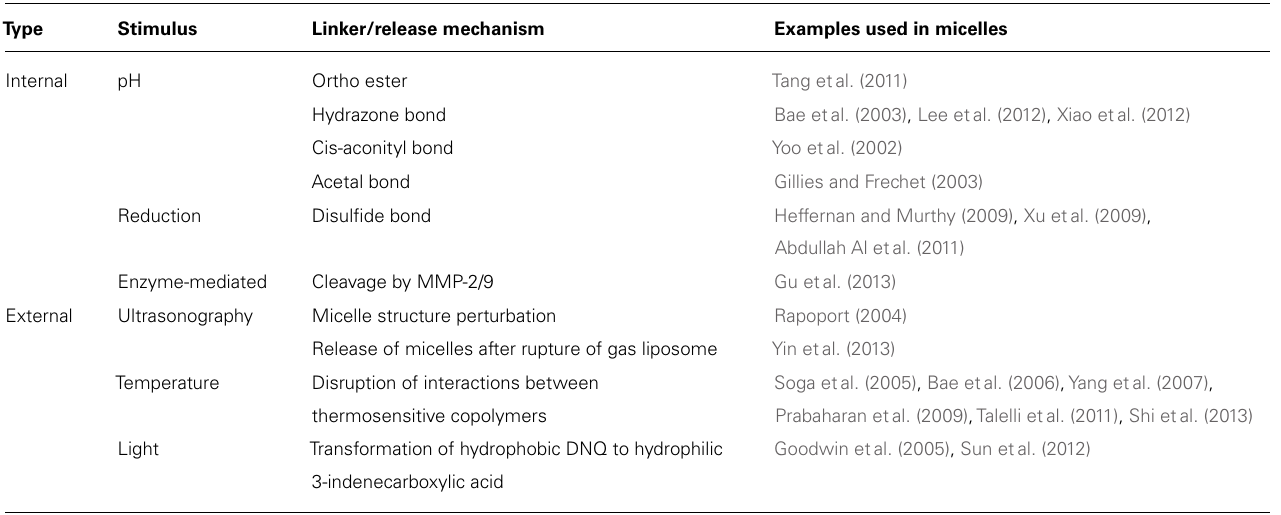
Table 1 | Stimulus-triggered release incorporated mechanism for micelle